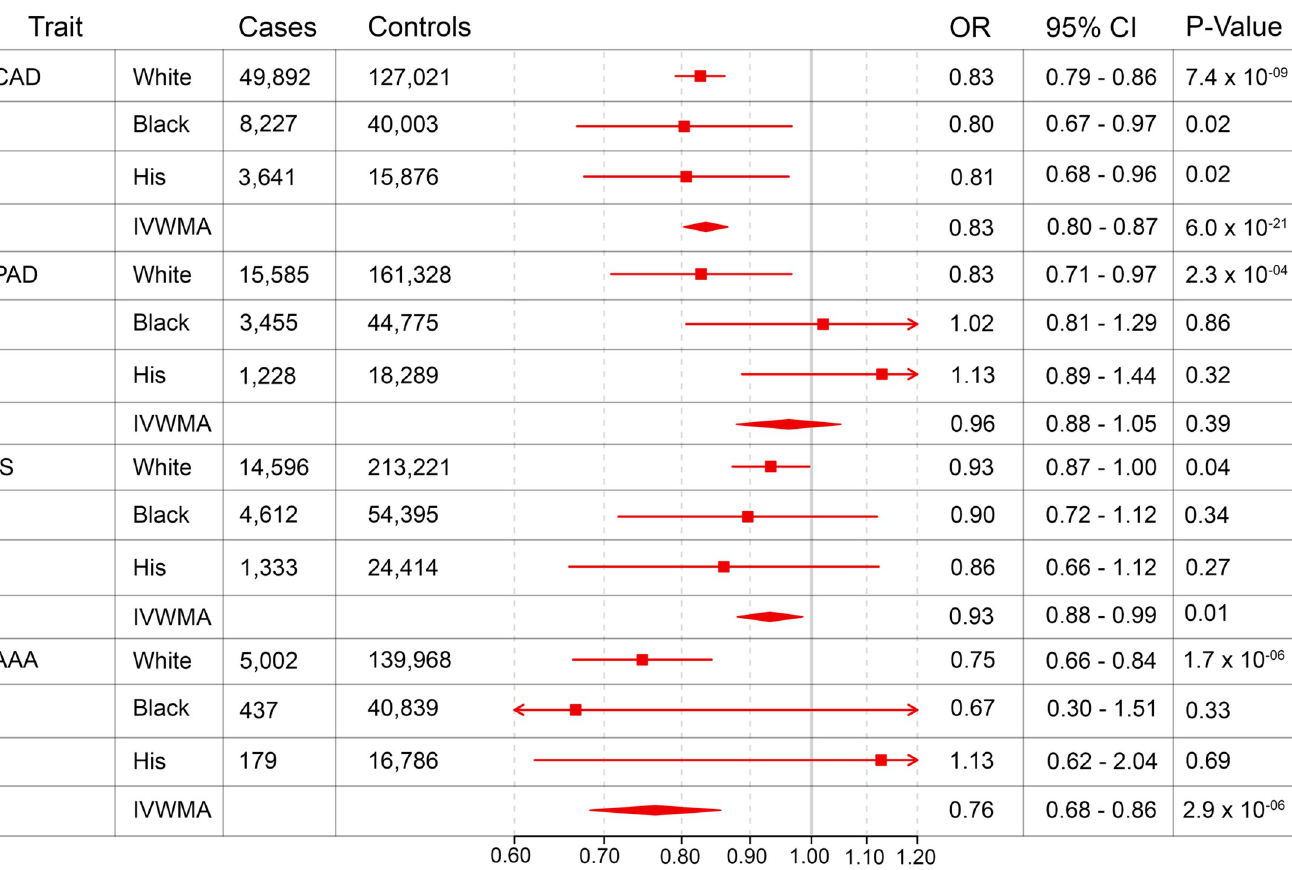
Fig 2. Weighted odds ratios reflecting the impact of a genetically determined 10 mg/dL decrease in LDL-C on pre-specified atherosclerotic traits. Odds Ratio and 95% confidence interval is displayed for the effect of a genetically determined 10 mg/dL decrease in LDL-C on primary atherosclerotic traits for White individuals, Black individuals, Hispanic individuals, and inverse variance weighted meta-analysis of White, Black, and Hispanic populations (IVWMA). All analyses were performed controlling for age, sex, and 5 ancestry-specific principal components.